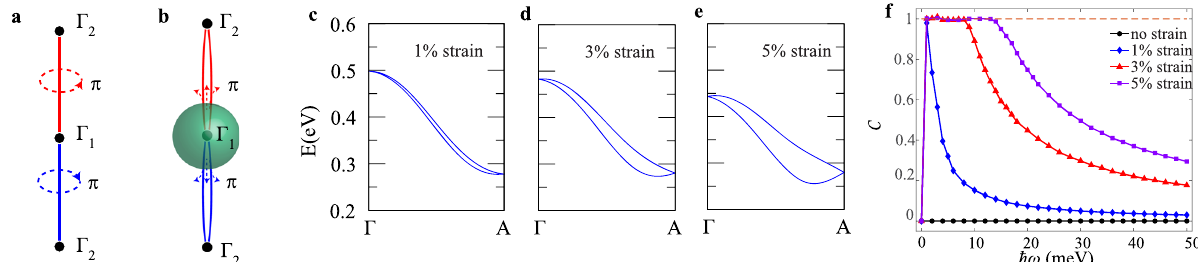
Fig. 4 Strain-induced Kramers Weyl fermions. a Schematic plot of a KNL (solid line) carrying Berry fl ux π . b The Berry fl ux emerges from TRIMs when the degeneracy of the KNL is lifted. The total fl ux through a sphere (in green) that enclose the TRIM is 2 π . c – e The splitting along Γ – A with 1%, 3%, and 5% strain strengths, respectively. f The chiral charge C versus light frequency ω , calculated at four different strain strengths: no strain (in black), 1% strain (in blue), 3% strain (in red), and 5% strain (in